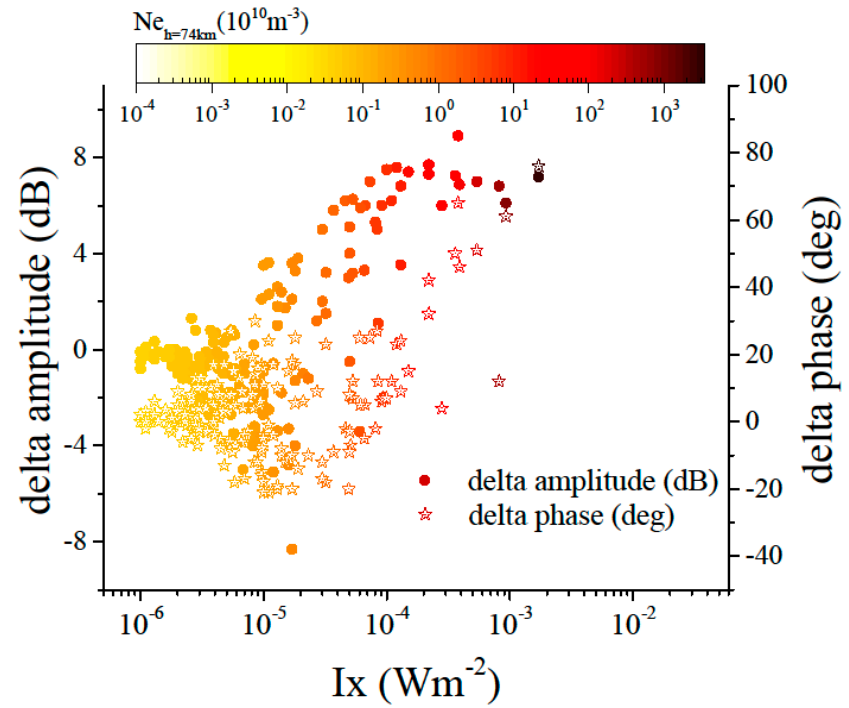
Figure 11. ( left ) Observed amplitude perturbations on GQD/22.10 radio signals, due to solar X-ray flares, measured at Belgrade during (2003–2017), as a function of X-ray flux. ( right ) Same as left but for observed phase perturbations. Two hundred events of solar X-ray flares were examined. Values of electron density at reference height, against maximum intensity of X-ray flux obtained by Equation (3) are presented. The color of the point is proportional to the electron density values change—darker color indicates larger values of electron density.